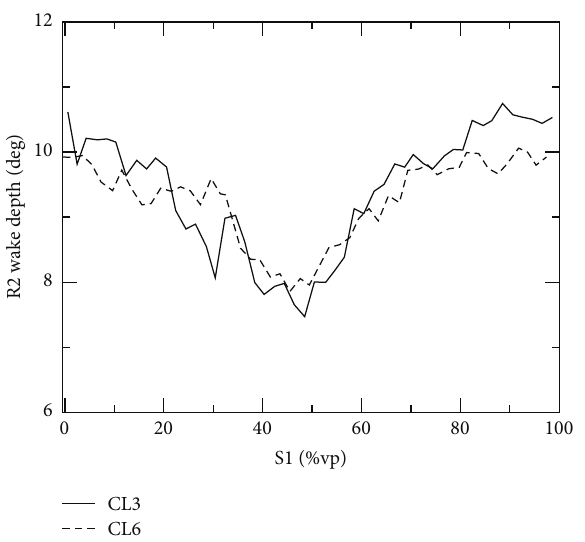
Figure 11: Rotor 2 wake depth at different locations across the vane passage.